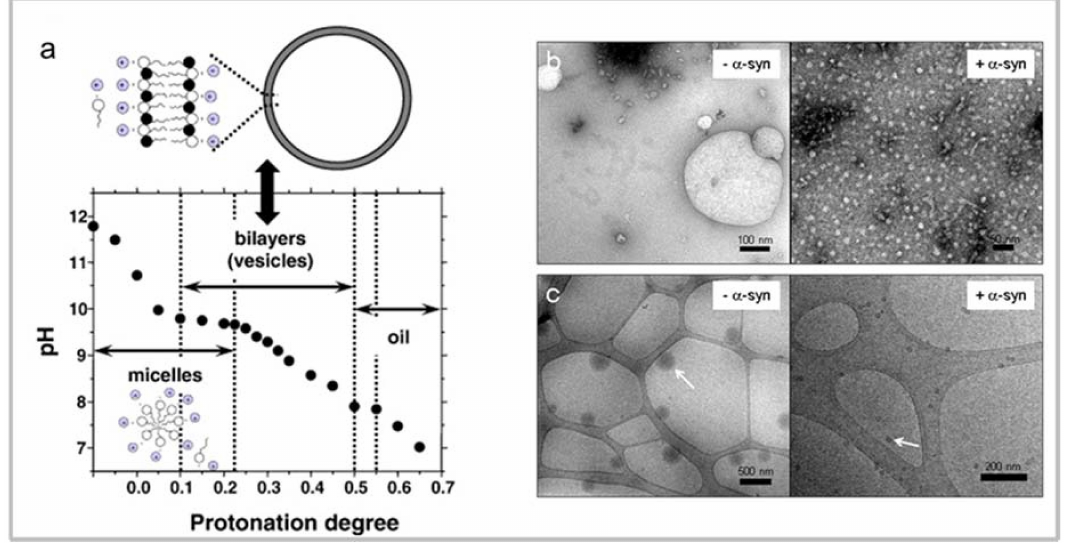
Figure 3. Biophysical properties of PUFAs. Titration curve for oleic acid/sodium oleate. ( a ) The plot indicates the regions for the formation of micelles, vesicles and oil droplets as a function of pH; Negative staining ( b ) and cryo ( c ) electron microscopy images of samples of DHA in the absence ( − α -syn) and in the presence (+ α -syn) of the protein. The arrows indicate the oil droplets. Taken, with permission, from